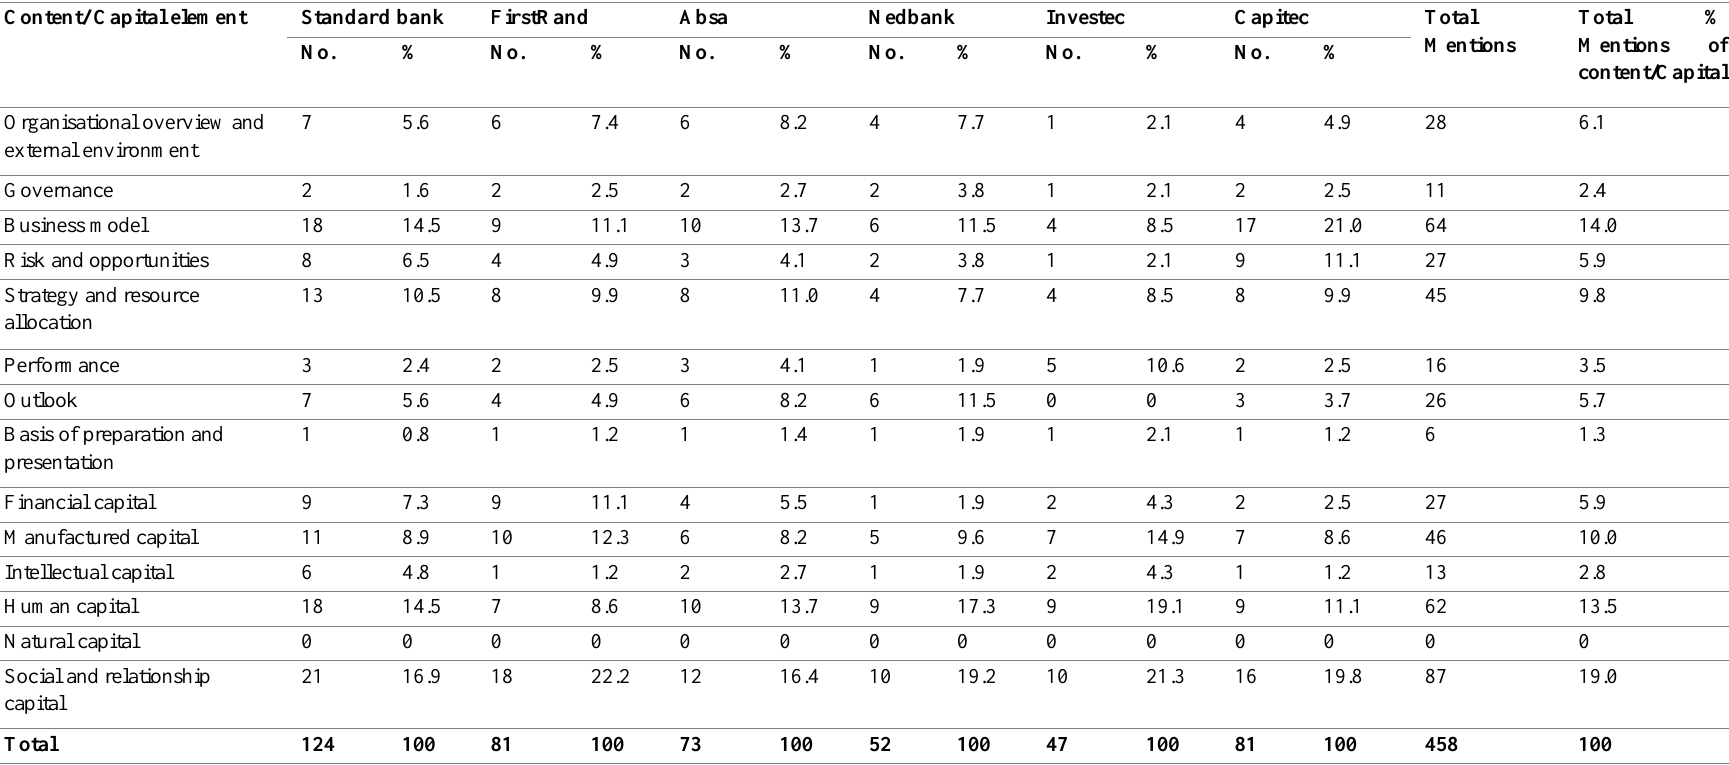
Table 2: Extent of COVID-19 pandemic report by six top 2021 South African